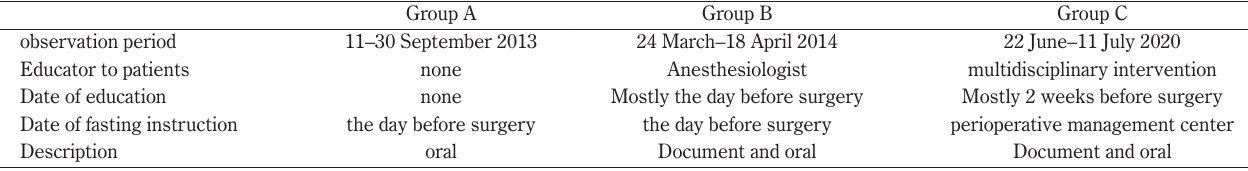
Table 1 Observation period and intervention method for each